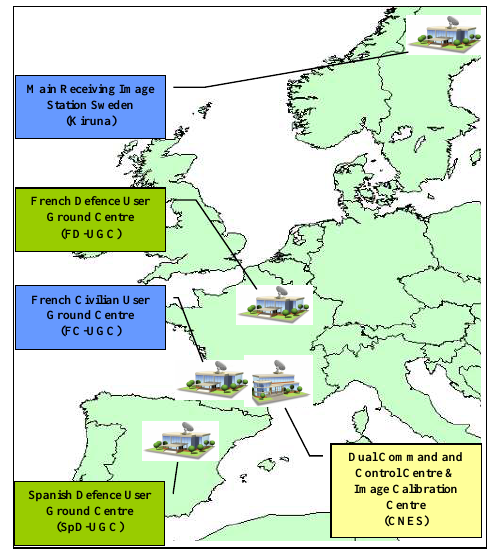
Figure 3: PLEIADES Main centers